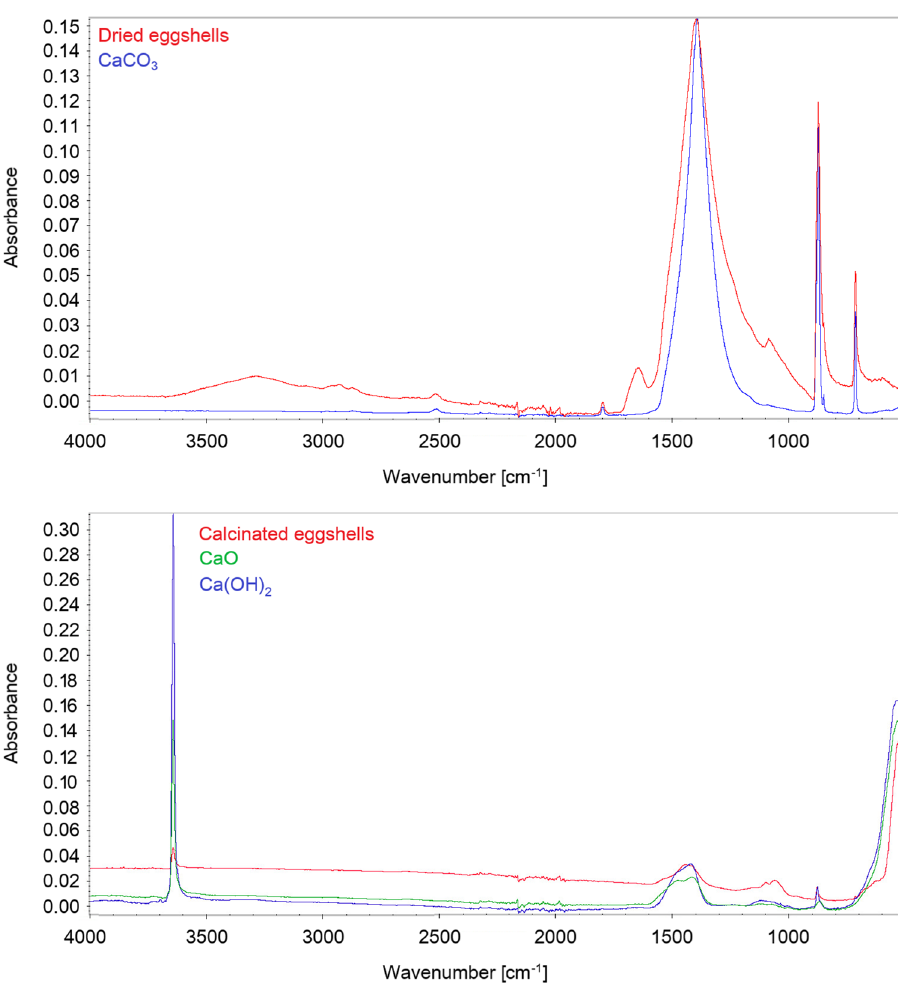
Figure 5. FT-IR spectra of dried eggshells and calcinated eggshells in comparison to CaCO 3, Ca(OH) 2 and